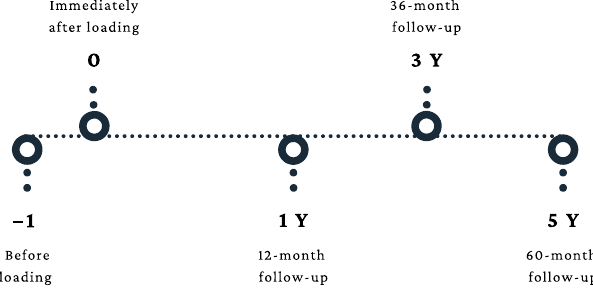
Figure 1. Timeline